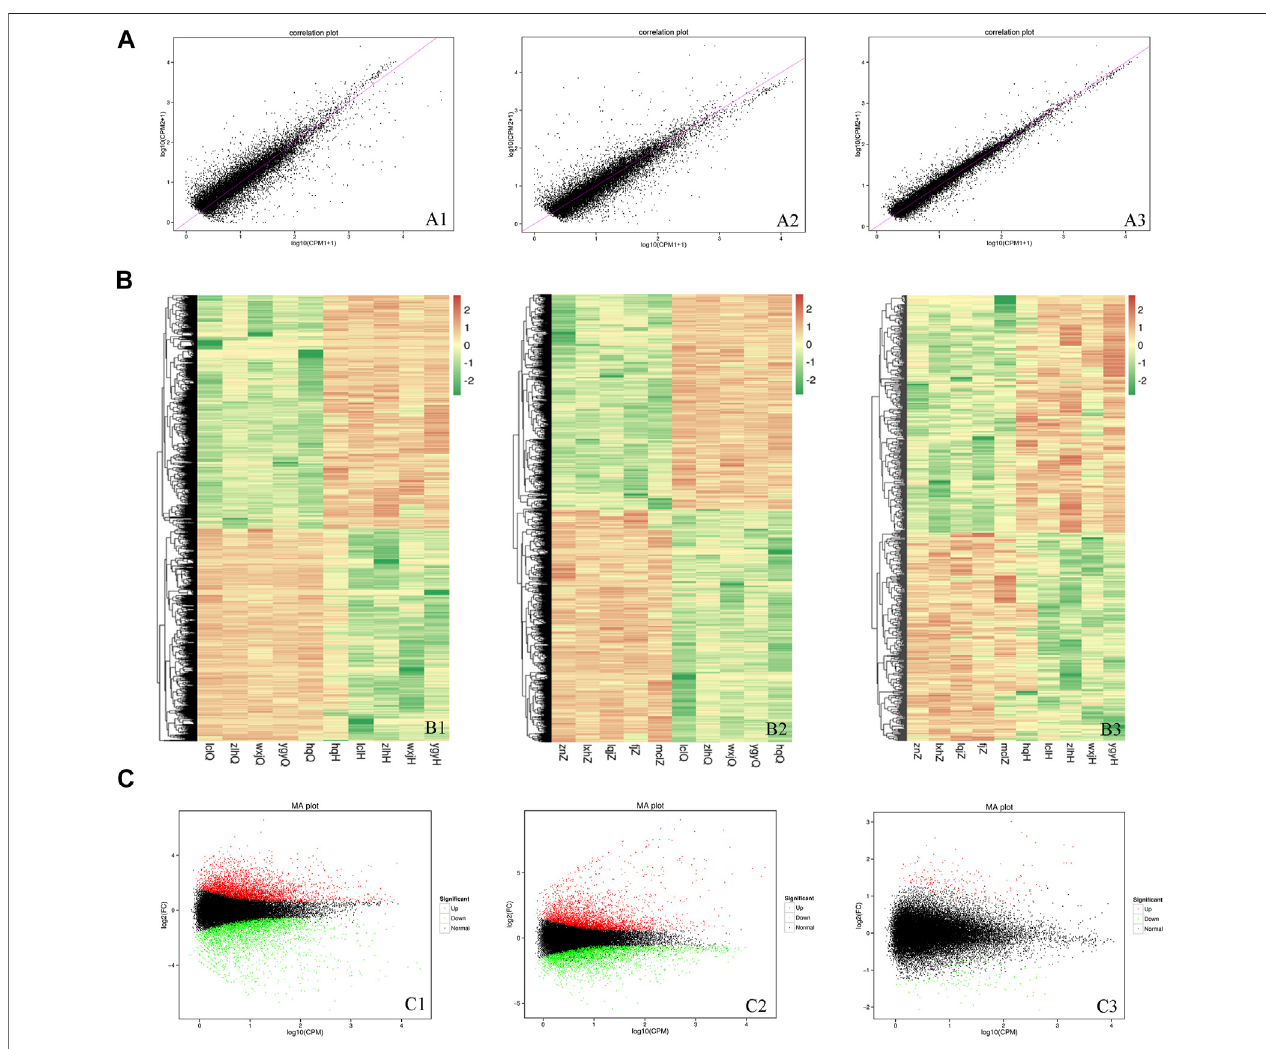
FIGURE 3 | DEGs. (A) Map of the expression correlations of all genes in the groups. Each point in the map represents a gene. The abscissa and ordinate correspond to the values of gene expression before and after oxymatrine treatment [log2 (CPM+1)]. (B) Heatmap. The abscissa represents the sample name and the sample cluster, and the ordinate represents the DEG and the gene cluster. The different lines represent different genes before vs. after oxymatrinetreatment. The colour representsthelevelofgeneexpressioninthesample[log2(CPM+1E-6)]. (C) MAmap.EachdotintheMAmapofDEGsrepresentsagene.Theabscissashowsthe A value [log2(CPM)], which is the logarithm of the mean expression quantity of the two samples. The ordinate shows the M value [log2(FC)], which is the logarithm of the FC in gene expression between the two samples (used to measure the difference in gene expression). Green dots represent downregulated DEGs, red dots represent upregulated DEGs, and black dots represent non-DEGs. A1, B1, C1(before vs. after oxymatrine treatment). A2, B2, C3(patients with psoriasis vs. normal controls). A3, B3, C3 (normal controls vs. patients after oxymatrine treatment).